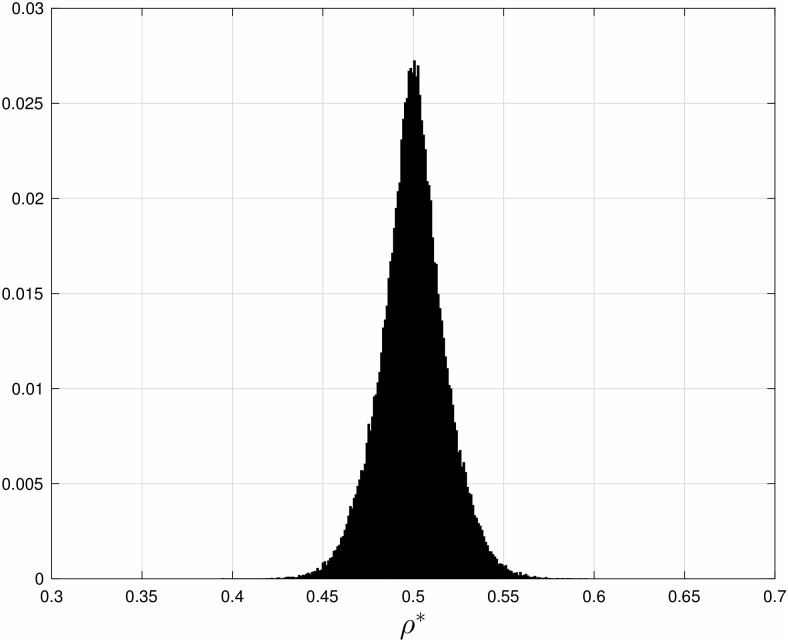
Normalized histogram of the optimal steady-state average density of ribosomes ρ* in Example 4.Data based on 105 random instances of solving the translation maximization problem (Problem 1) for an RFM with length n = 11 sites, and total budget b = 1 (see Problem 1). It may be observed that typically ρ* is close to 1/2.